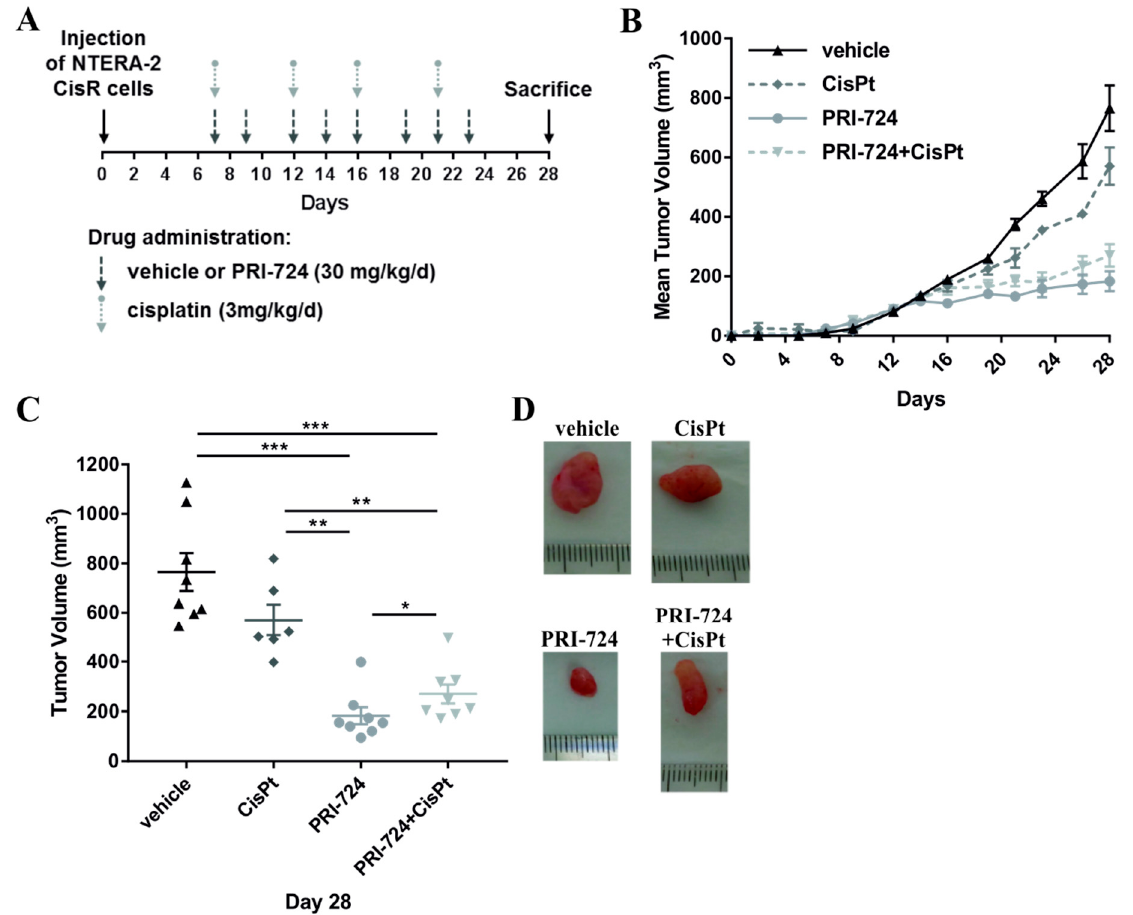
Figure 10. PRI-724 exhibited antitumorigenic effect on NTERA-2 CisR xenografts in vivo. ( A ) Outline scheme of the treatment. Cisplatin, PRI-724 and vehicle were intraperitoneally administered to mice. The timing of drug administration is indicated by arrows. ( B ) PRI-724 significantly inhibited the growth of NTERA-2 CisR xenografts. ( C ) The tumor sizes were significantly smaller in the group of mice treated with PRI-724 alone compared to control group (vehicle) or to mice treated with cisplatin. Cisplatin did not enhance antitumorigenic effect of PRI-724. ( D ) Images of representative tumors at the end of the experiment showing the antitumorigenic effect of Wnt/ β -catenin/CBP inhibition by PRI-724. * p < 0.05, ** p < 0.01, *** p < 0.001.